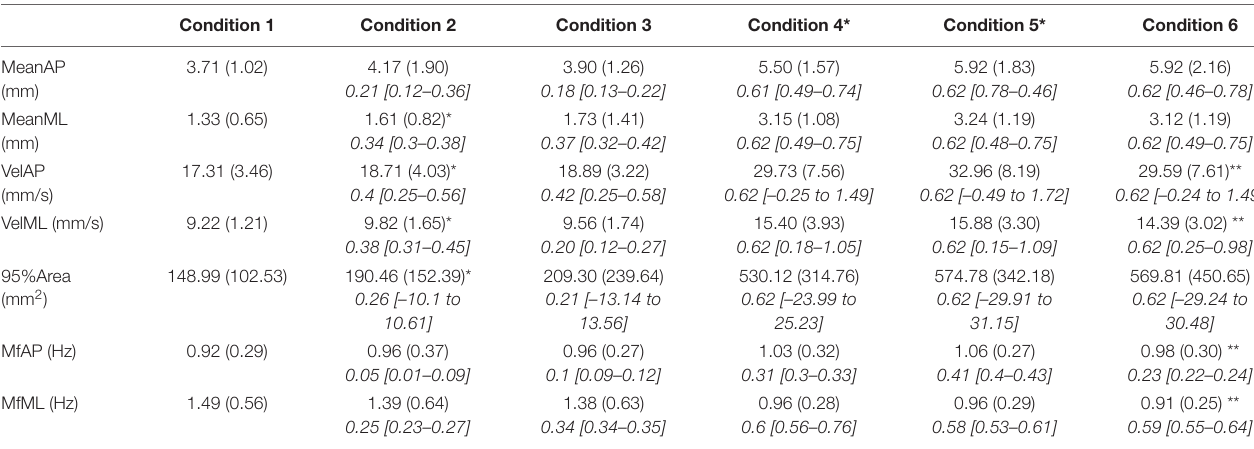
TABLE 2 | COP-based measures across the six VR-ComBAT conditions ( N = 23).